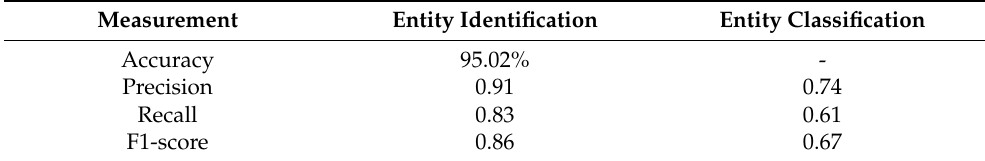
Table 1. Recognition performance of BERT-CRF.